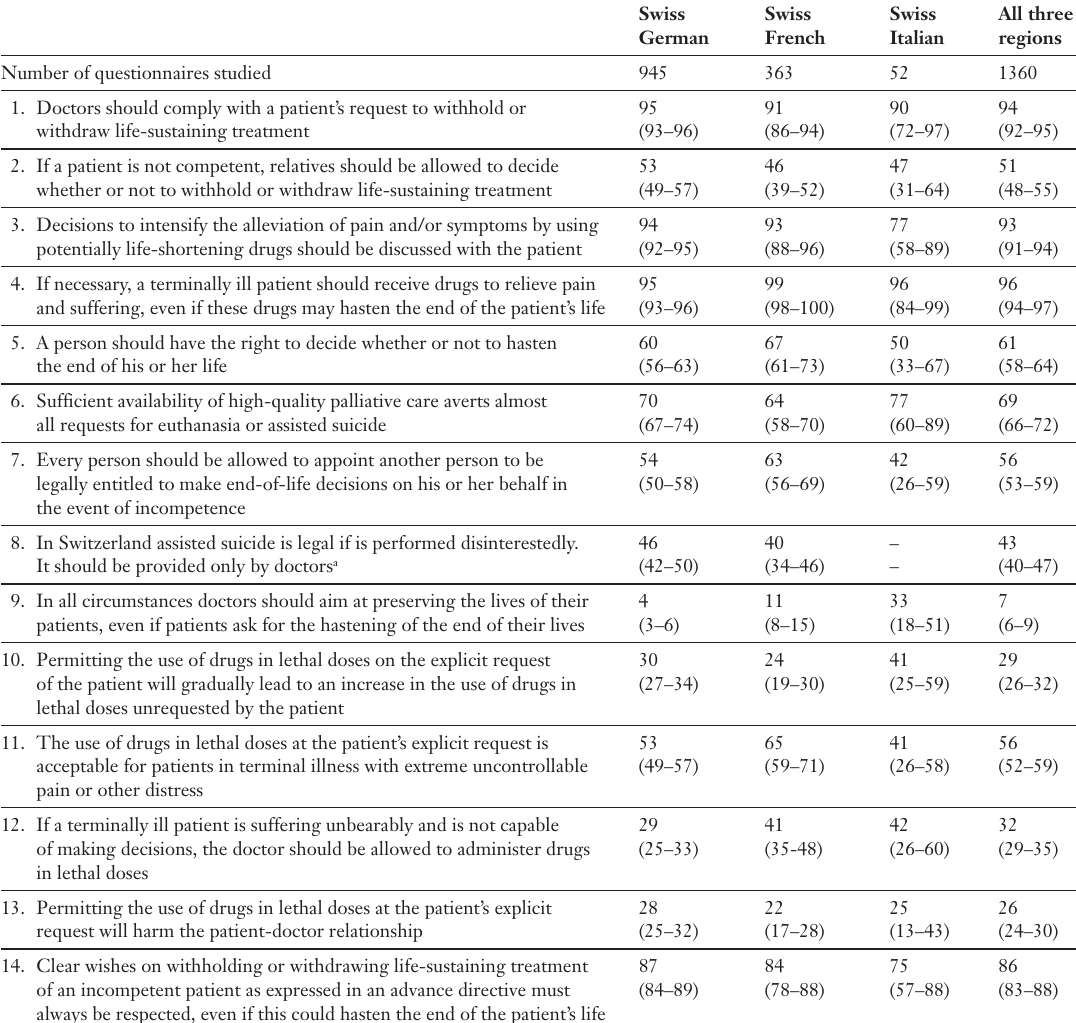
Table 2 Weighted percentage (95% CI) of doctors who agreed or strongly agreed with each statement on end-of-life